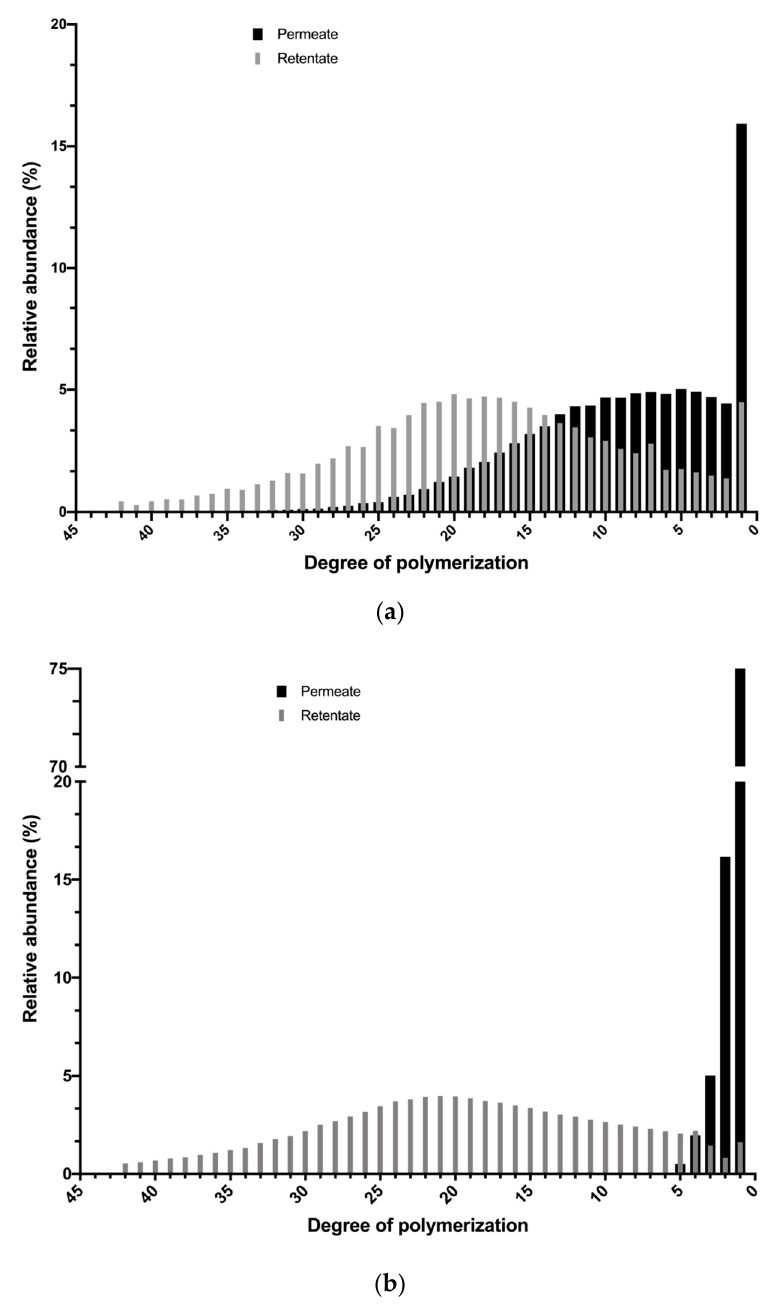
Figure 8. Fructan size distribution histograms of the final retentate and permeate solutions obtained with ceramic ( a ) and polymeric ( b ) membrane systems for a batch process.